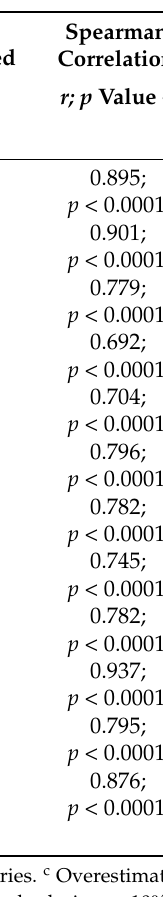
Table 1. Students’ performance of food identification and quantification of two-dimensional (2-D) and 3-D digital food models in the first semester ( n =